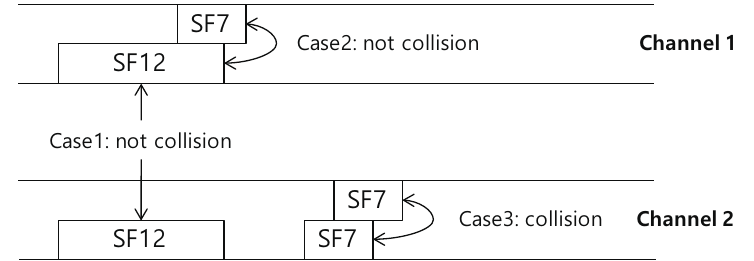
Figure 2. Multiple access control in the pure-ALOHA based the